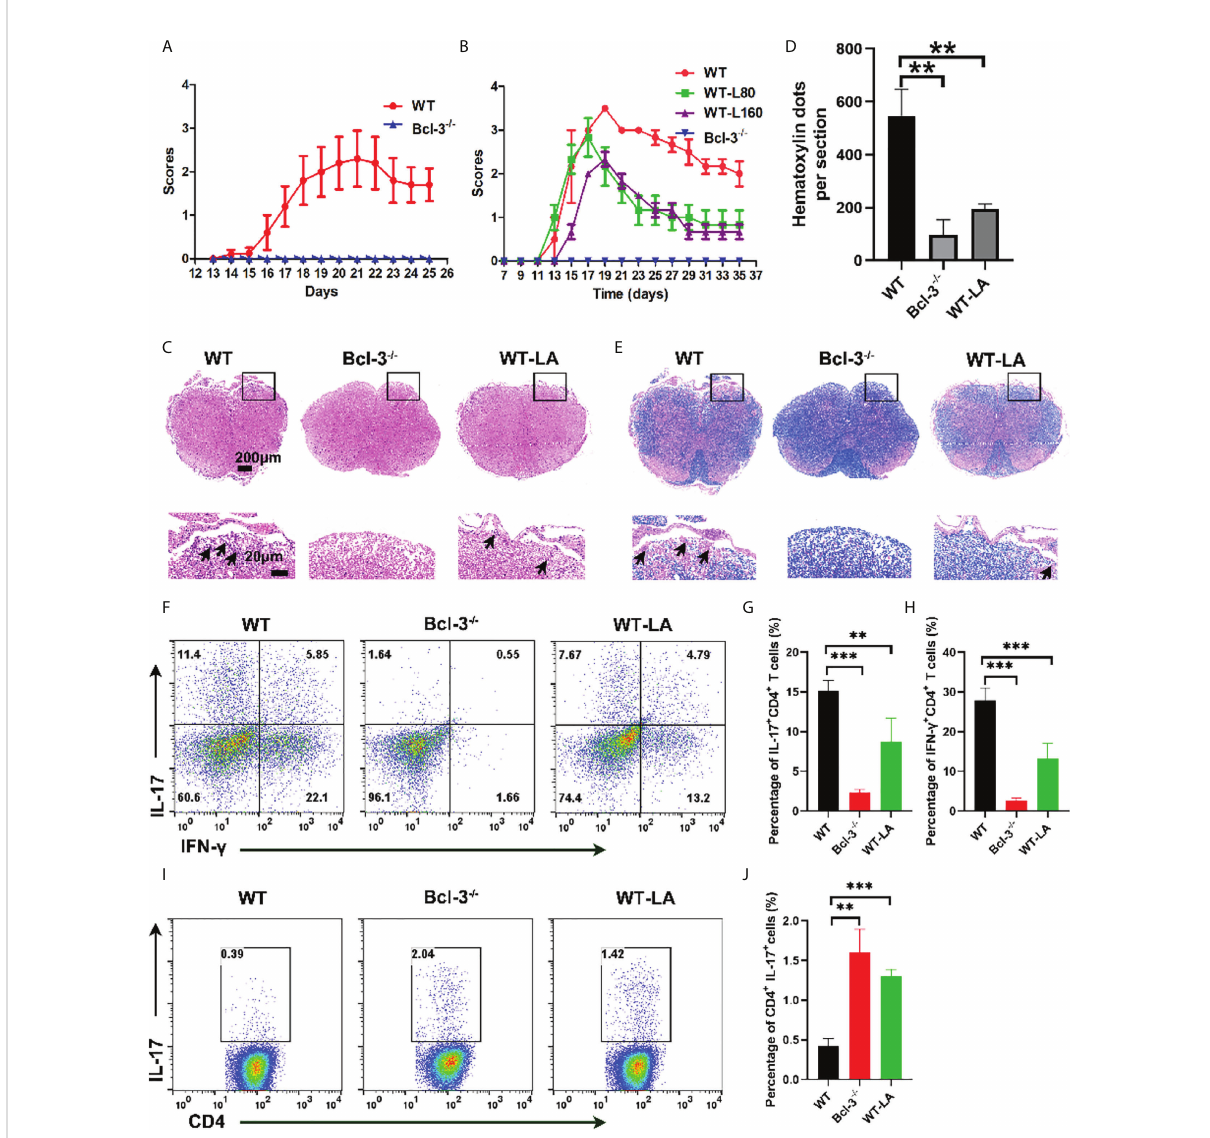
FIGURE 6 Bcl-3 de fi ciency alleviates EAE progression through lactate. (A) Clinical score of Bcl-3 -/- and WT mice after inducing EAE disease (n = 5). (B) Bcl- 3 -/- and WT mice were induced EAE, and one group of WT mice received 160 mg/kg lactate i.p. three days later; clinical score of EAE is evaluated every other day. (C) Spinal cords were isolated from mice on day 18 after immunization and fi xed for haematoxylin & eosin staining, and in fi ltration of lymphocytes was highlighted with arrow. (D) Quantitative analysis of disease severity. (E) Spinal cords were isolated from mice on day 18 after immunization and fi xed for LFB staining to analyze demyelination highlighted by arrow. (F) Representative staining of Th17 cells in CNS on day 18 post immunization. Represented dots were gated on TCR b + CD4 + (G – H) statistical analysis of IL-17 + CD4 + cells and IFN- g + CD4 + cells in the CNS. (I) Representative staining of Th17 cells in draining lymph nodes on day 14 post immunization. Represented dots were gated on CD4 + (J) statistical analysis of IL-17 + CD4 + cells in the draining lymph nodes. Data above are representative of 3